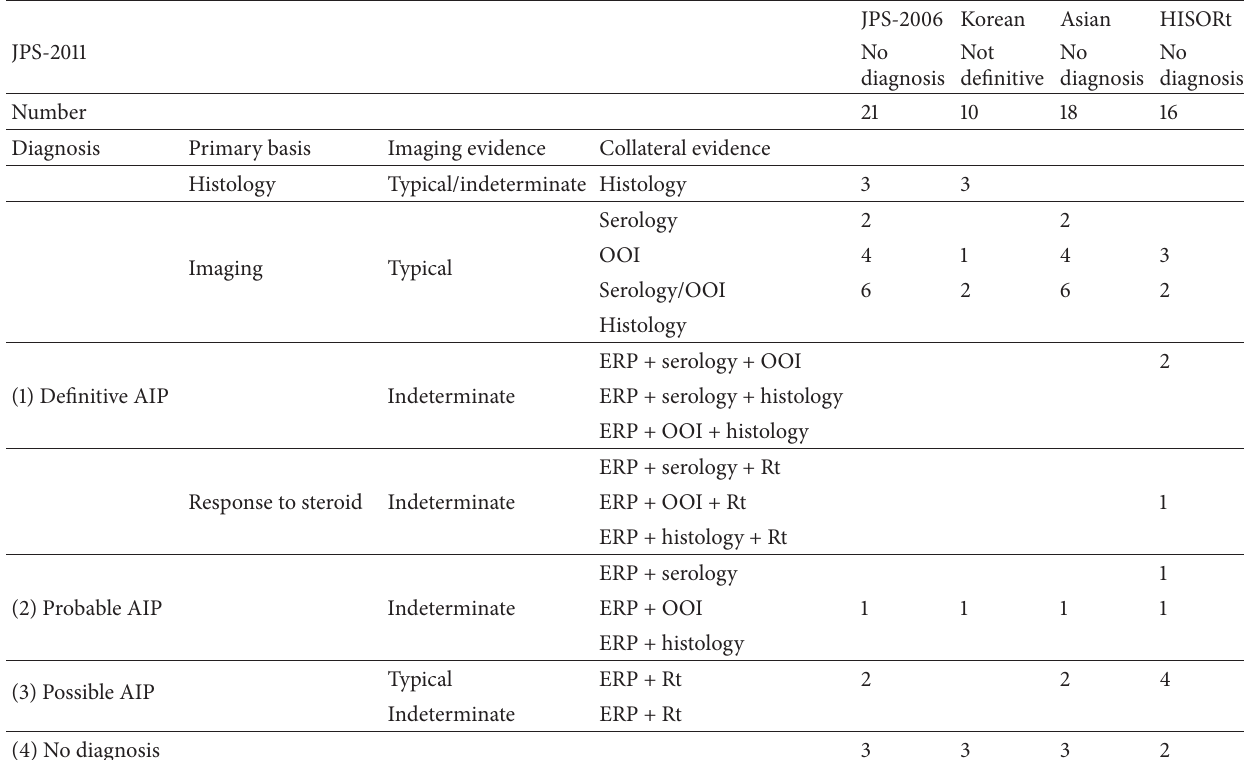
Table 4: JPS-2011 diagnosis of negative AIP cases determined by earlier sets of